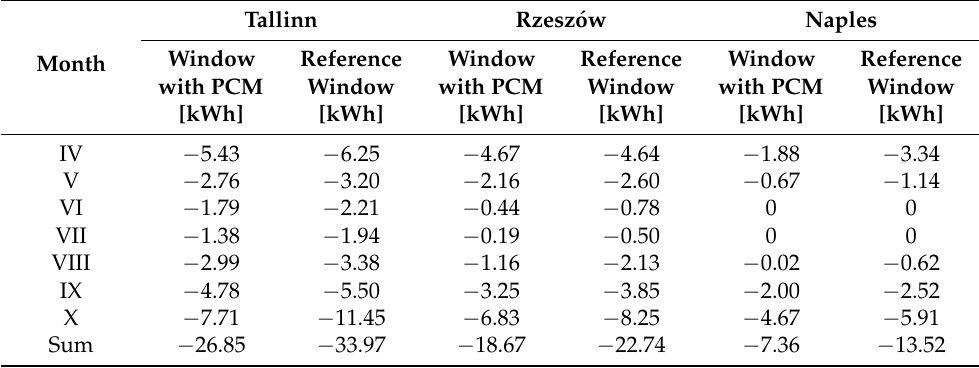
Figure 15. Summary of monthly heat balances through windows with a PCM accumulator and reference windows in Tallinn, Rzesz ó w and Naples. Table 1. Heat losses through windows with a PCM accumulator and reference windows operating in cool temperate (Tallinn), temperate (Rzesz ó w) and subtropical (Naples) climates.